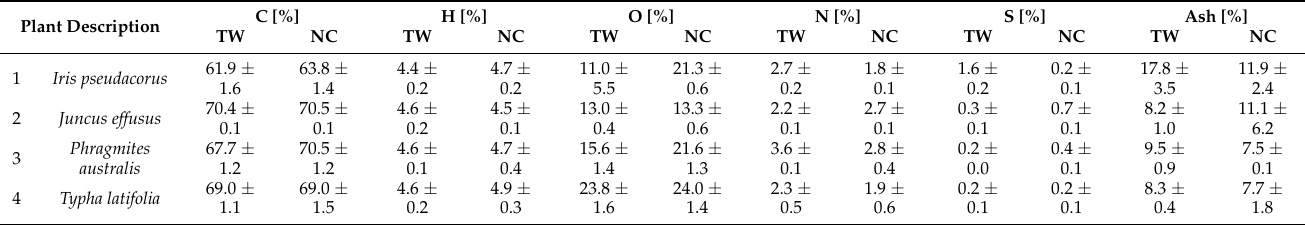
Table 5. C, H, O, N, S and ash content in the biochar produced by the selected plants for the different growing environments. Plant Description